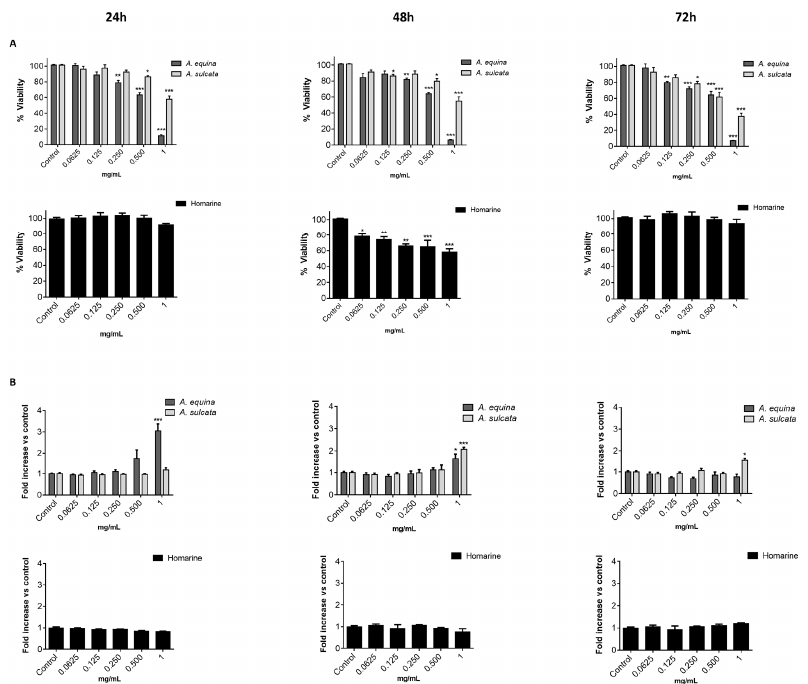
Figure 2. ( A ) Viability of RAW 264.7 macrophages treated with aqueous extracts of A. equina and A. sulcata and pure alkaloid homarine for 24, 48, and 72 h; ( B ) Evaluation of membrane integrity in RAW 264.7 macrophages. After 24, 48, and 72 h of exposure with the extracts and homarine, lactate dehydrogenase (LDH) was quantified. Statistical significance: * p < 0.05, ** p < 0.01, *** p < 0.001.